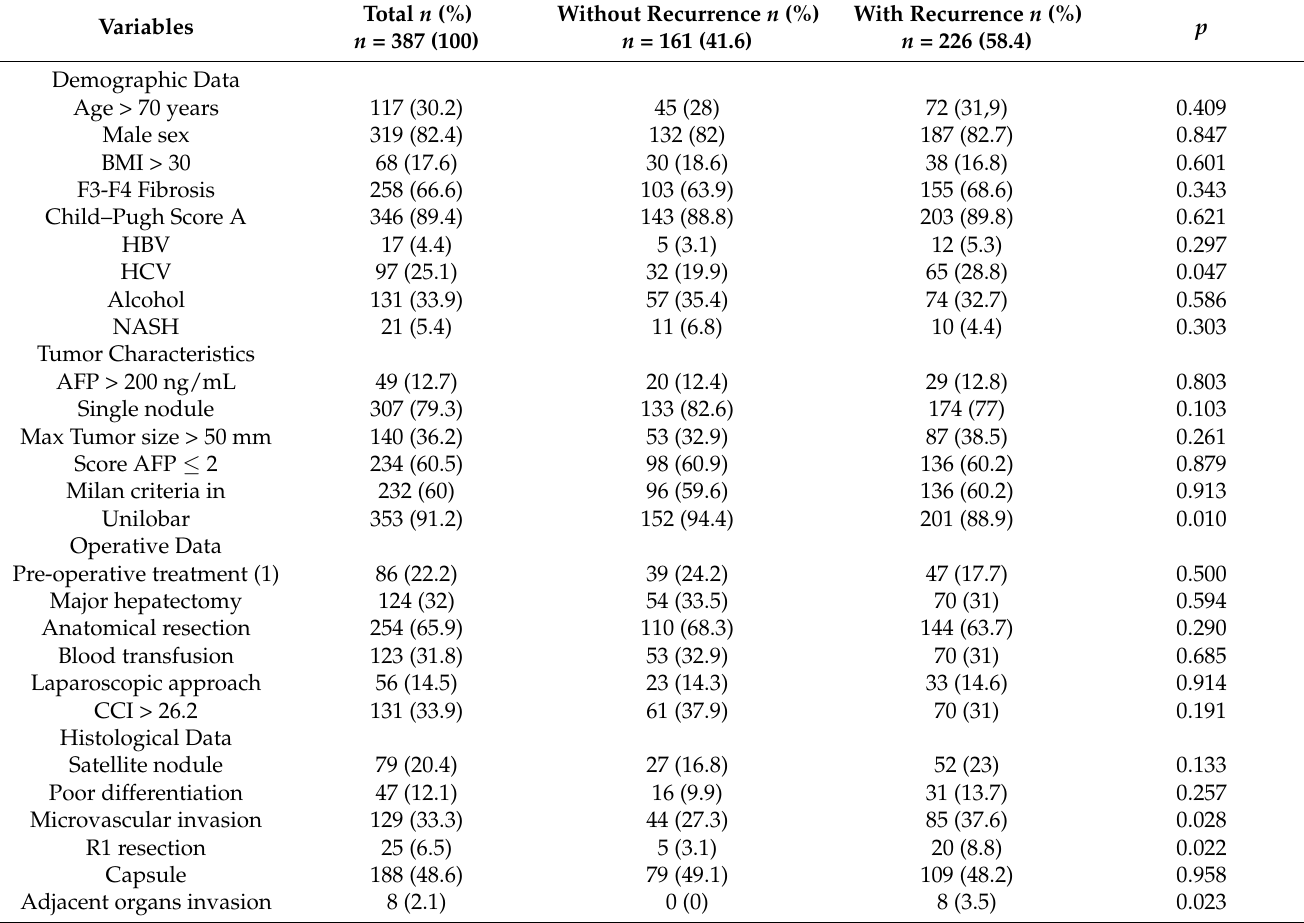
Table 1. Comparisons of clinical characteristics between patients with or without